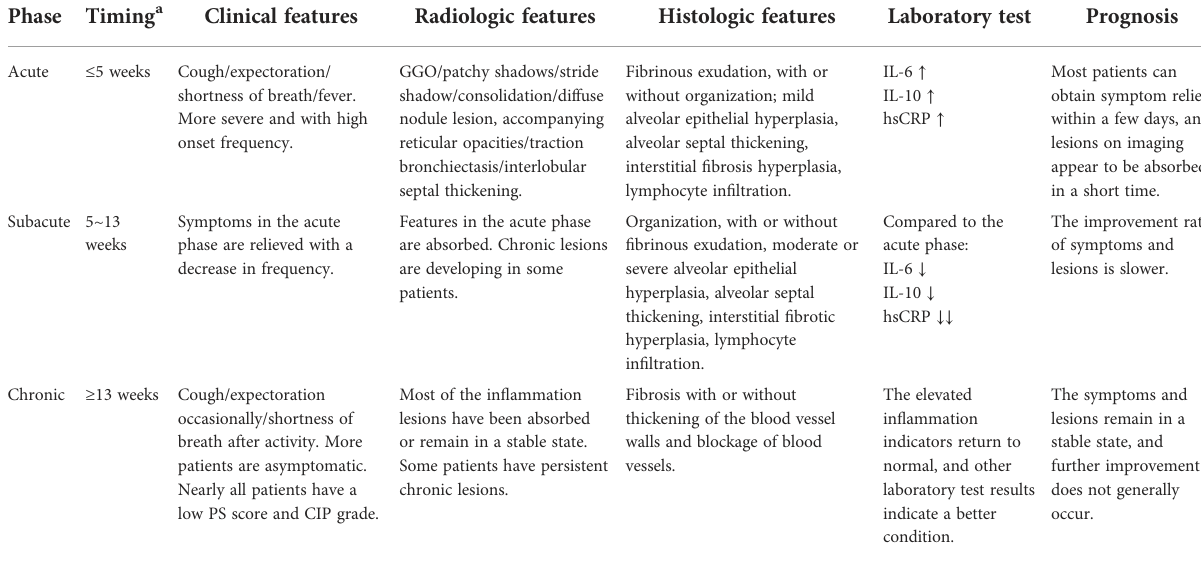
TABLE 3 Features of checkpoint inhibitor-related pneumonitis (CIP) in different